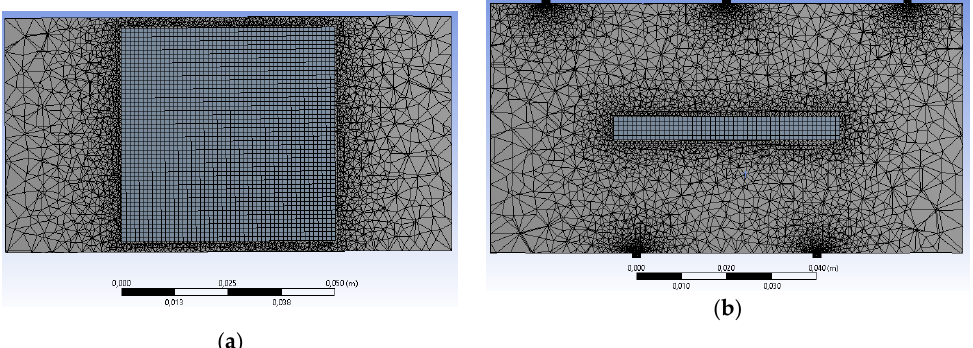
Figure 4. XZ ( a ) and YZ ( b ) cross sections of the initial mesh.